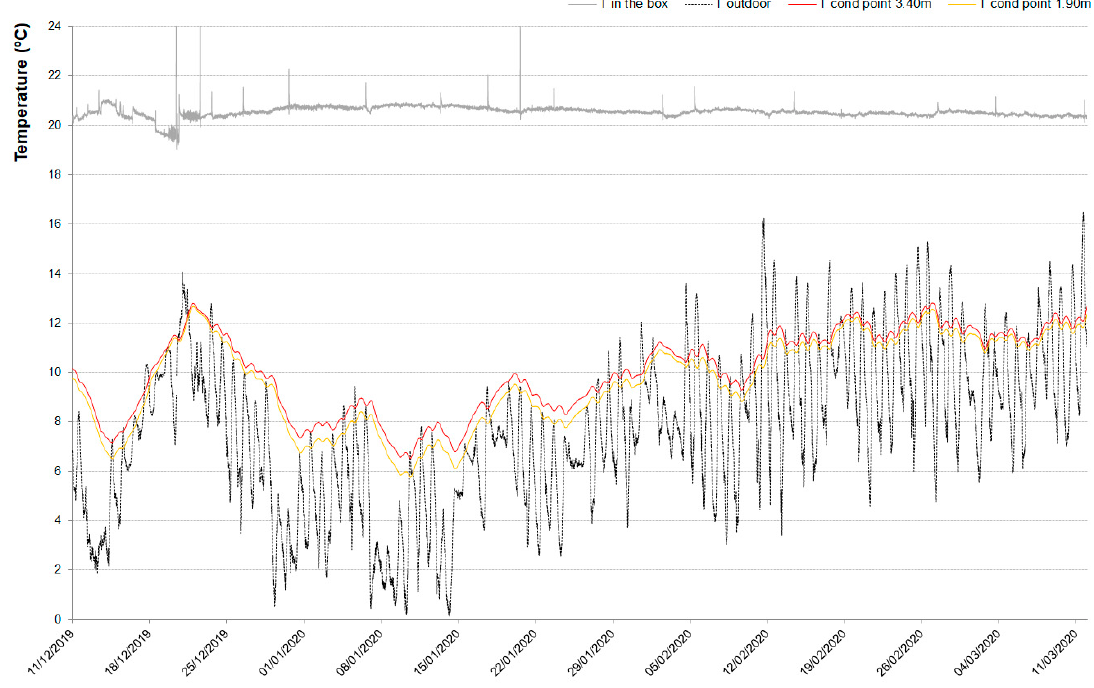
Figure 11. Graphical representation of the T values between 11 December 2019 and 11 March 2020.